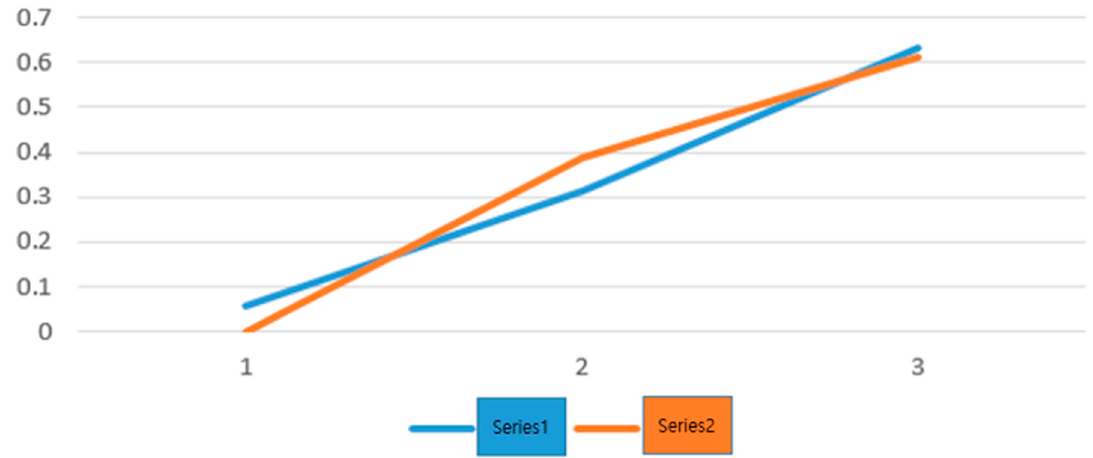
Figure 15. Comparison between the appearance frequency of “intense heat” and maximum power (“Living Culture” section of Naver news, 2016).